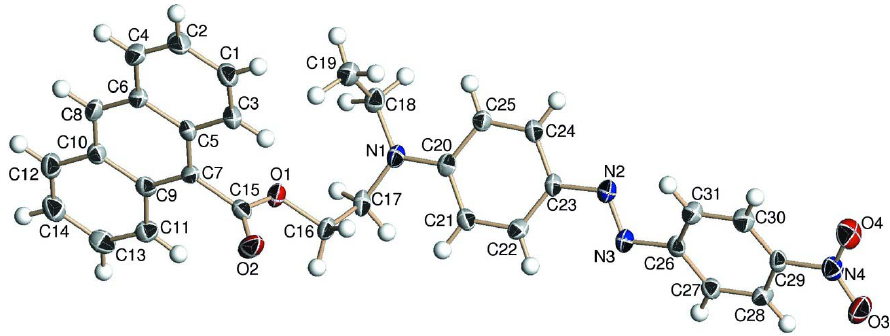
Figure 1 The molecular structure of (I), with atom labels and 50% probability displacement ellipsoids for non-H atoms.